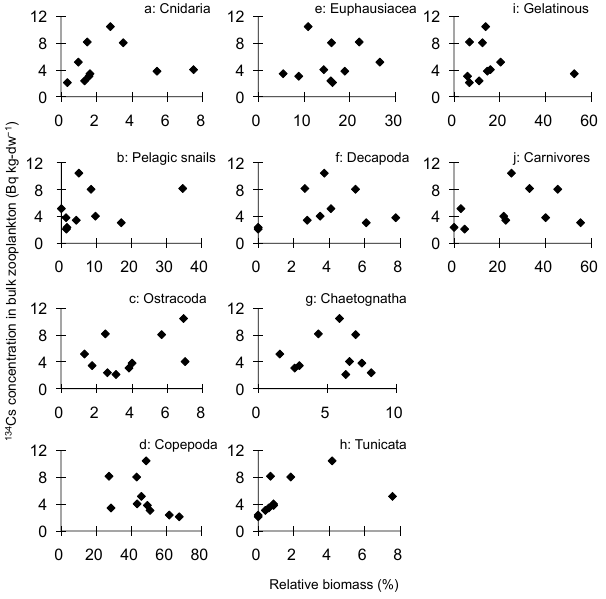
134 Cs activity concentration in bulk zooplankton communities (a– h) , between relative biomass of gelatinous zooplankton (Cnidaria, Chaetognatha and Tunicata) and 134 Cs in bulk zooplankton (i) , and between relative biomass of carnivores and 134 Cs in bulk zooplank- ton (j) . All the activities were decay corrected to the date of sam-